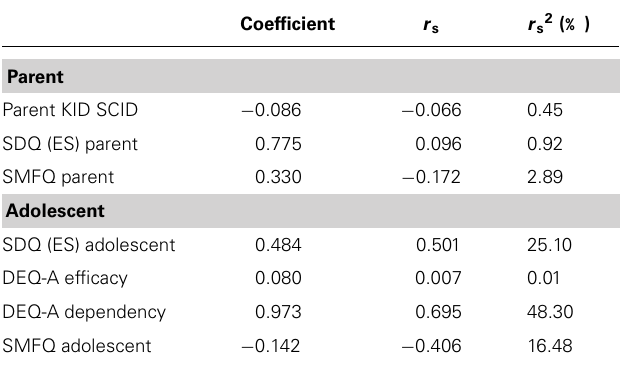
Table 3 | Standardized discriminant function and structure coefficient for diagnosis and no diagnosis groups on theAdolescent KID-SCID, major depressive